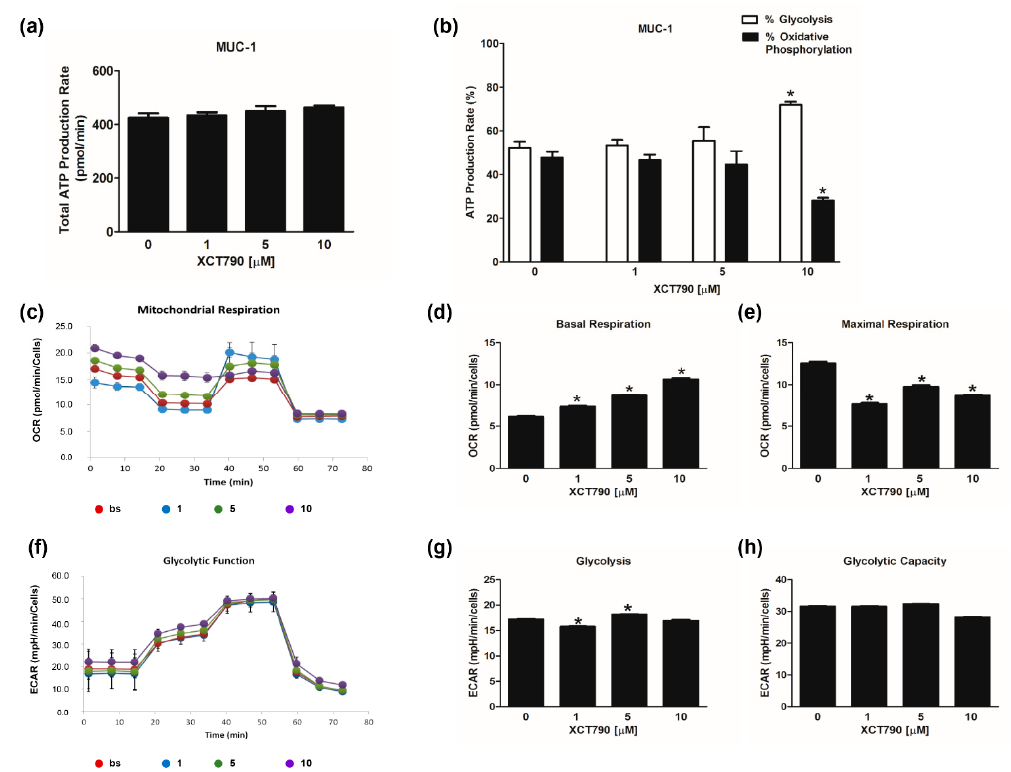
Figure 4. Effect of XCT790 treatment on SW13 cell metabolism. The metabolic profiles of SW13 cells untreated (0) or treated with XCT790 (1, 5, 10 µM) for 18 h were assessed by Seahorse XFe96 analyzer. ( a , b ) ATP Rate Assay was evaluated as indicated in “Materials and Methods”. Graphs represent the mean ± SD of three independent experiments of Total ATP Production Rate (pmol/min) ( a ) and ATP production (%) ( b ) derived from glycolysis and oxidative phosphorylation after the sequential addition of specific inhibitors (* p < 0.05 vs. 0). ( c – e ) Mitochondrial Stress Analysis was performed as indicated in “Materials and Methods”. Graphs represent the mean ± SD of three independent experiments of real-time oxygen consumption (OCR) rate (pmol/min/cells) (* p < 0.05 vs. 0). Mitochondrial Respiration( c ), Basal Respiration ( d ), Maximal Respiration ( e ) were measured from OCR after the addition of specific inhibitors. ( f – h ) Glycolytic Stress Analysis was performed as indicated in “Materials and Methods”. Graphs represent the mean ± SD of three independent experiments of real-time extracellular acidification (ECAR) rate (mpH/min/cells); (* p < 0.05 vs. 0). Glycolitic function ( f ), Glycolysis ( g ) and Glycolytic Capacity ( h ) were measured from ECAR after the addition of specific inhibitors.